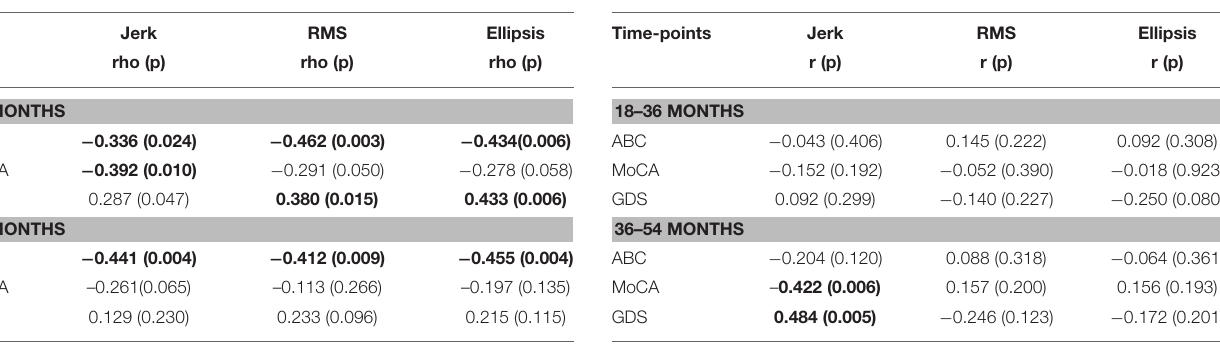
TABLE 3 | Spearman’s correlation coefficient for mean postural parameters of jerk, RMS, and ellipsis in the AP direction across 120s with clinical characteristics at 36 and 54 months.